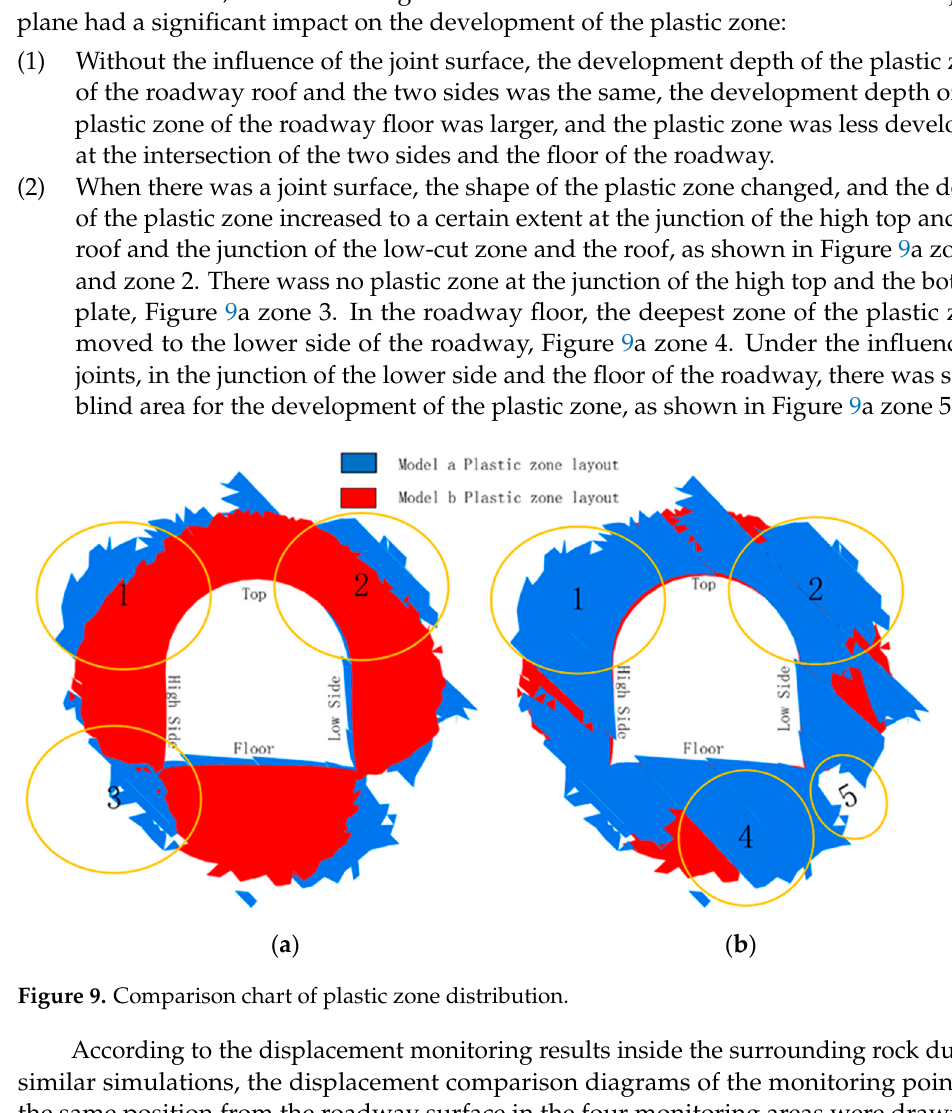
Figure 8. The numerical simulation model.